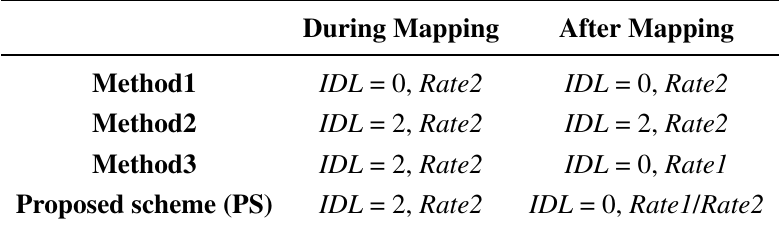
Table 3. Description of the methods’